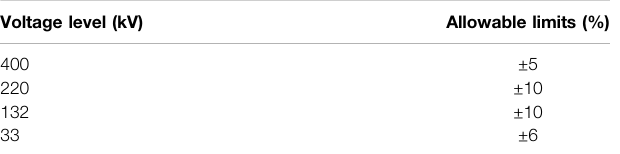
TABLE 1 | Percentage of the allowable limits for different transmission voltage levels. Voltage level (kV) Allowable limits